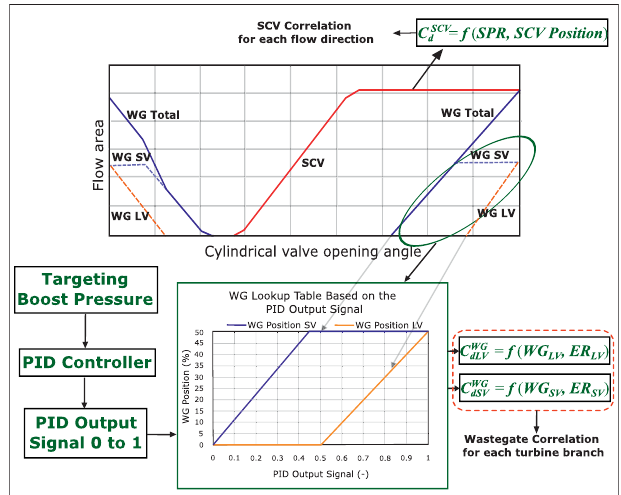
FIGURE7| Methodology for simulatingwhen the wastegate fl ow areais the same and when SCV is opened.